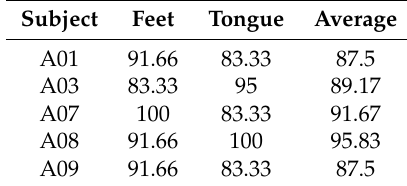
Table 5. The label-wise accuracies (%) of five subjects of BCI